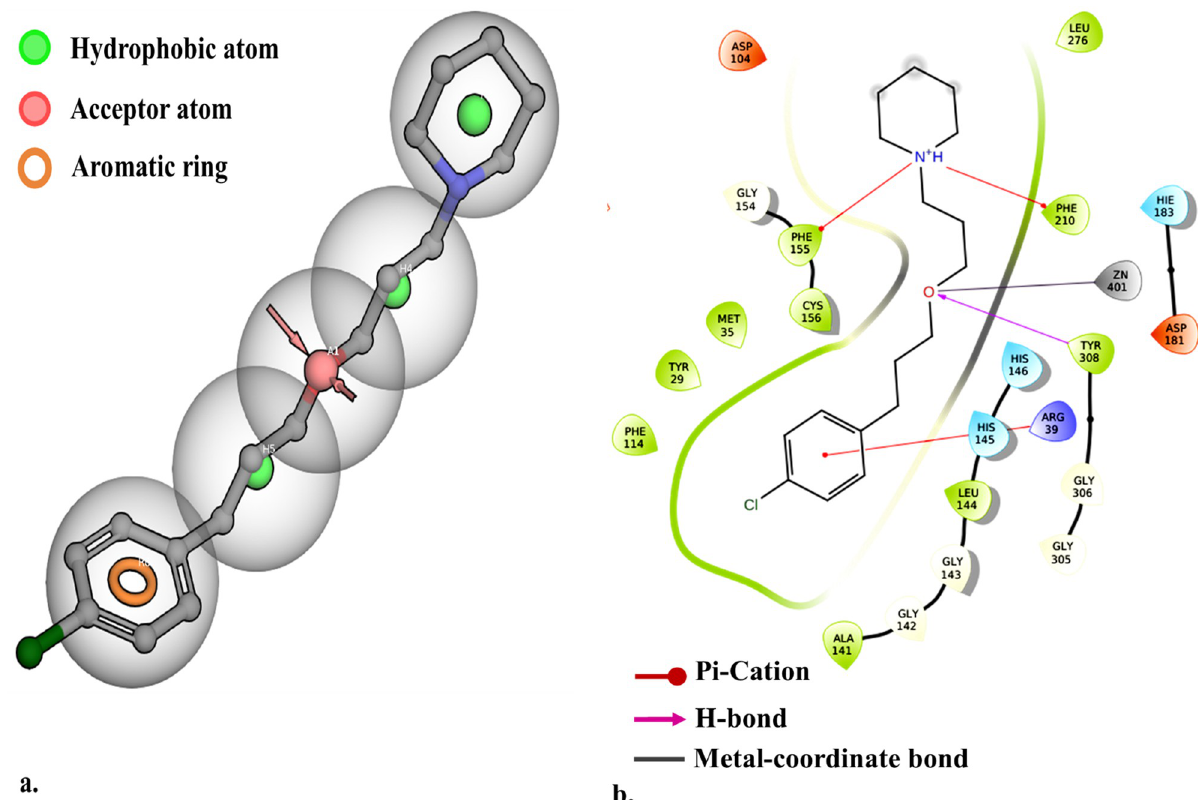
Fig 4. (A) Pharmacophore hypothesis using pitolisant as a model molecule and, (B) 2D interaction diagram of molecular docking of pitolisant at HDAC2 binding site.